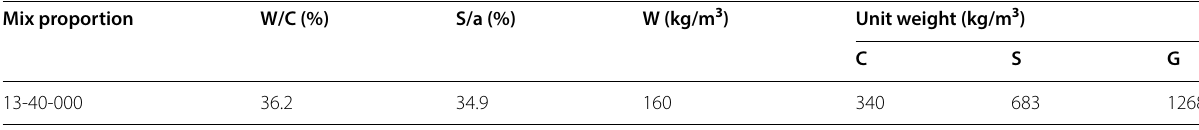
Table 1 Concrete mix design used for test specimens. Mix